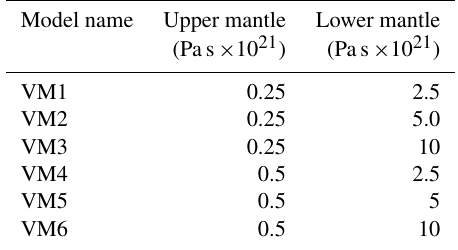
Table 1. Upper and lower mantle viscosities for the different Earth